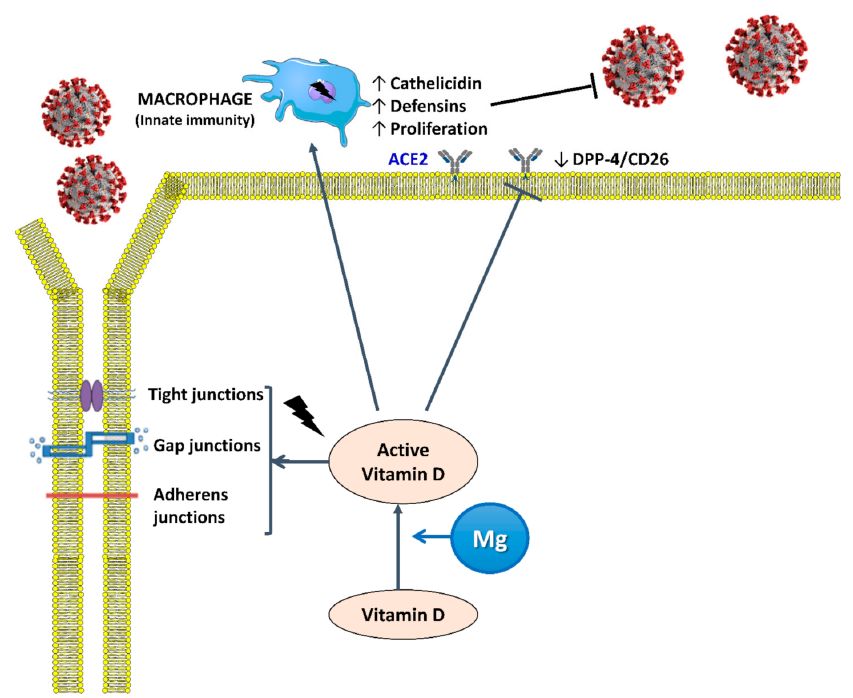
Figure 3. Active vitamin D (calcitriol or dihydroxycholecalciferol) helps maintain tight junctions, gap junctions, and adherens junctions in order to prevent the spread of SARS-CoV2 and induces the proliferation of macrophages and the release of cathelicidin and defensins, which are antimicrobial peptides active against a spectrum of microbes including viruses. Mg is a cofactor that is necessary for the synthesis, transport, and activation of vitamin D. ACE2: angiotensin-converting enzyme 2 receptor; DPP-4/CD26: dipeptidyl peptidase-4